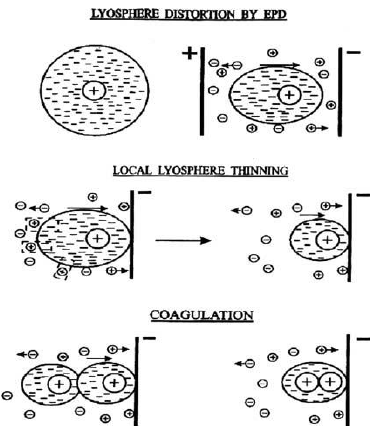
Figure 2. Schematic representation of the deposition mechanism due to electrical double layer distortion and